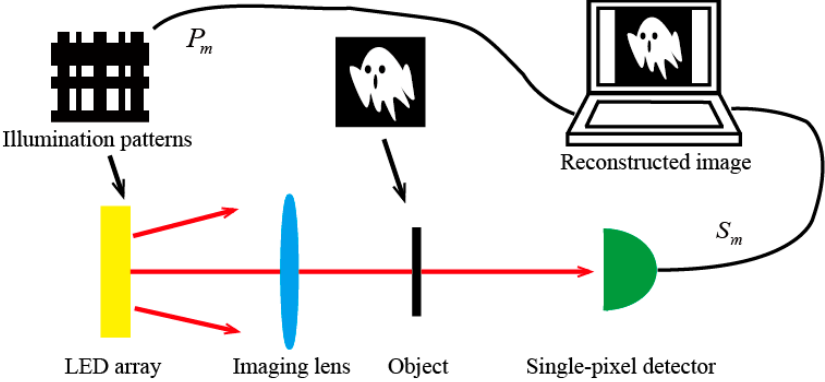
Figure 1. Simplified LED-based computational ghost imaging scheme.